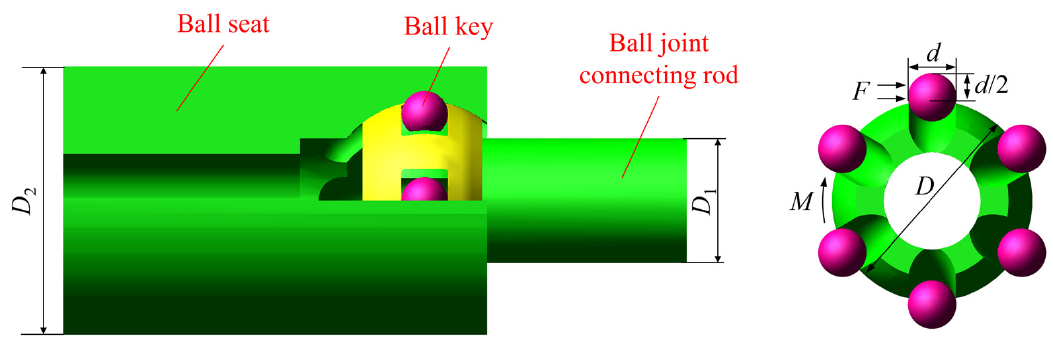
Figure 4. Mechanical analysis model of ball key and ball head. As shown in Figure 4, flexible joint torque ( M ) from the equilibrium condition